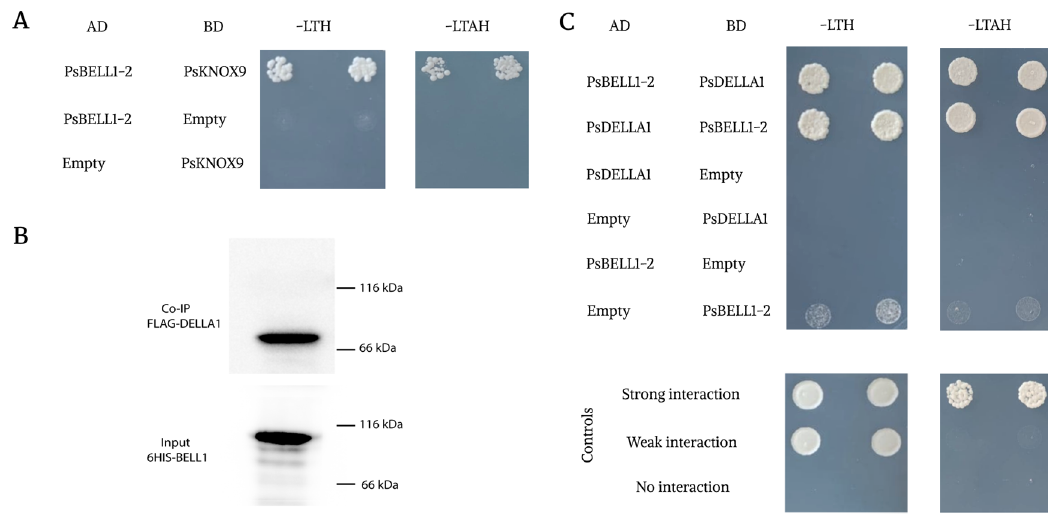
Figure 5. Analysis of the interaction between PsBELL1-2, PsKNOX9 and PsBELL1-2, PsDELLA1 using di ff erent approaches. Yeast two-hybrid assays between PsBELL1-2 and PsKNOX9 ( A ), PsBELL1-2 and PsDELLA1 ( C ). Co-immunoprecipitation (Co-IP) between PsDELLA1-FLAG and PsBELL1-2 ( B ). For the yeast two-hybrid assays, serial dilutions optical density at 600 nm (OD600) = 0.1 and 0.05 were used. Interaction was tested on a selective medium lacking leucine, tryptophan, and histidine (SD-LTH) and medium additionally lacking adenine (SC-LTAH). Yeast growth on indicated mediums shows the protein interaction. As controls, a few pairs of vectors (pEXP32 / Krev1 and pEXP22 / RalGDS-wild type, pEXP22 / RalGDS-m1, and pEXP22 / RalGDS-m2) suggested by the manufacturer (Thermo